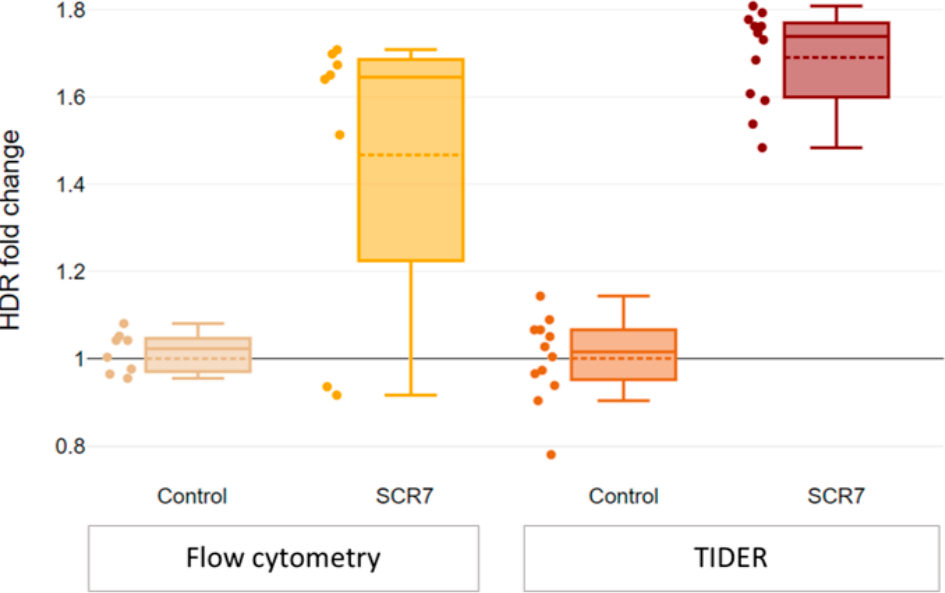
Figure 4. SCR7 increases HDR efficiency (dashed line represents mean, solid line—median, whiskers—95% CI). HDR efficiency increases upon the addition of SCR7 compared to Cas9-sgRNA/ssODN editing without SCR7: a ~1.5-fold increase in the number of GFP+ cells ( p = 0.1) and a 1.6–1.8-fold increase in the number of the corrected alleles ( p = 0.0004).